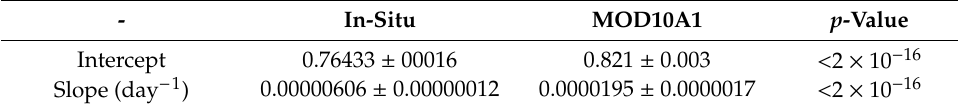
Table 9. Slope and intercept of the linear fit of the albedo trend values versus